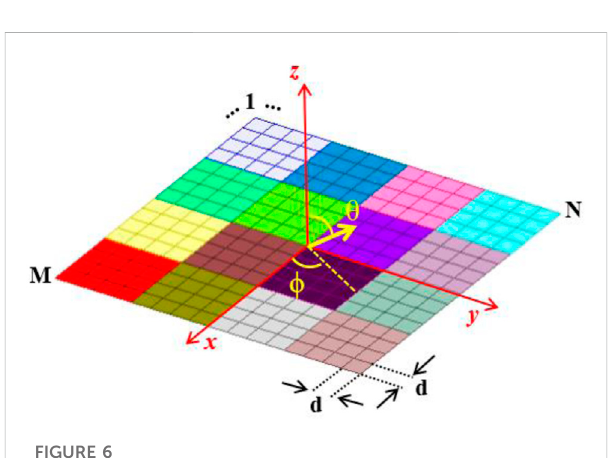
FIGURE 6 RIS representation for phase distribution de fi